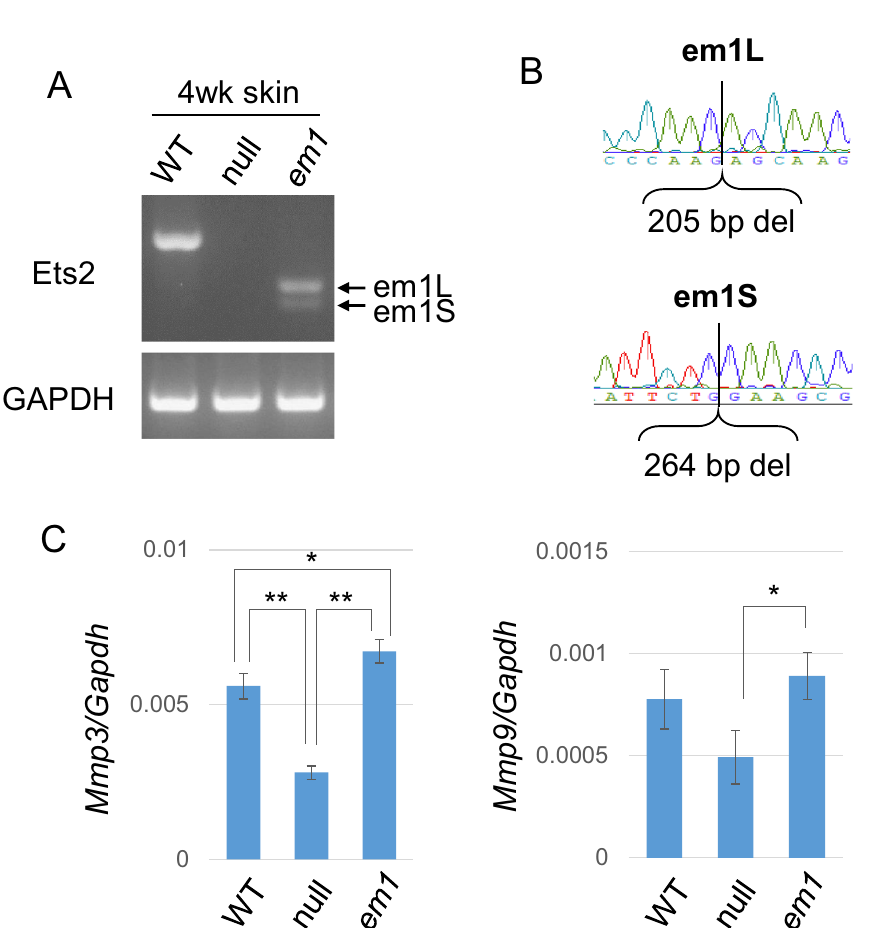
Figure 4. Gene expression in the Ets2 em1/em1 skin. (A) Gene expression from the Ets2 locus in skins of WT, Ets2 null(em3/em3) mutant (null) and Ets2 em1/em1 (em1) mice. From em1 skin, two types of mRNA were